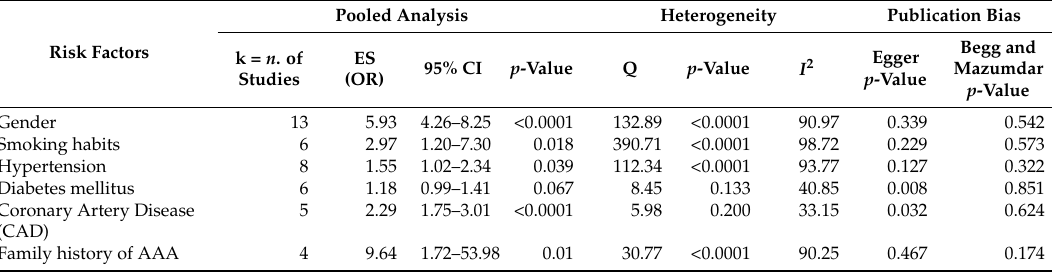
Figure 2. Gender. ( A ) Forest plot (N1 Male; N2 Female); ( B ) sensitivity analysis; ( C ) cumulative analysis; ( D ) funnel plot. Table 2. Meta-analysis with studies including male and female.